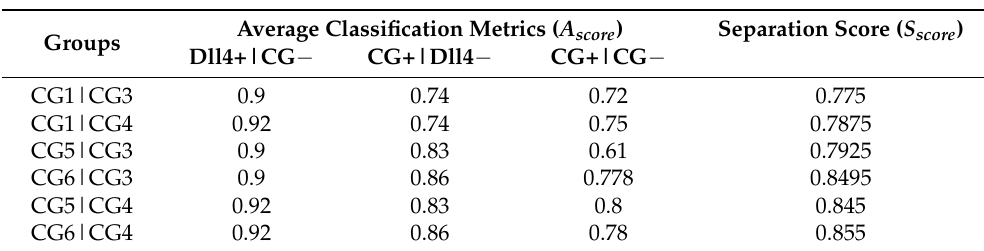
Table 1. Separation score for group pairs. Average Classification Metrics ( A score Groups